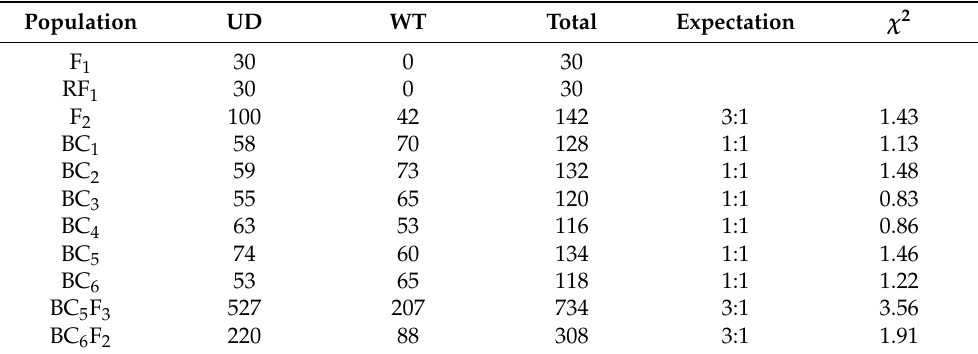
Table 1. Inheritance of the leaf up-curling and silique downward-pointing traits in populations derived from the two parents in B. napus